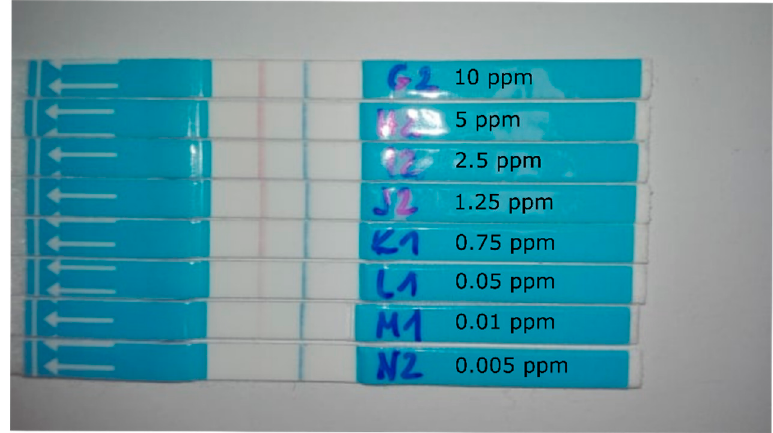
Figure 5. A set of LFAs used to build a calibration curve for gluten quantification with various smartphones. The concentrations of gluten used are indicated.